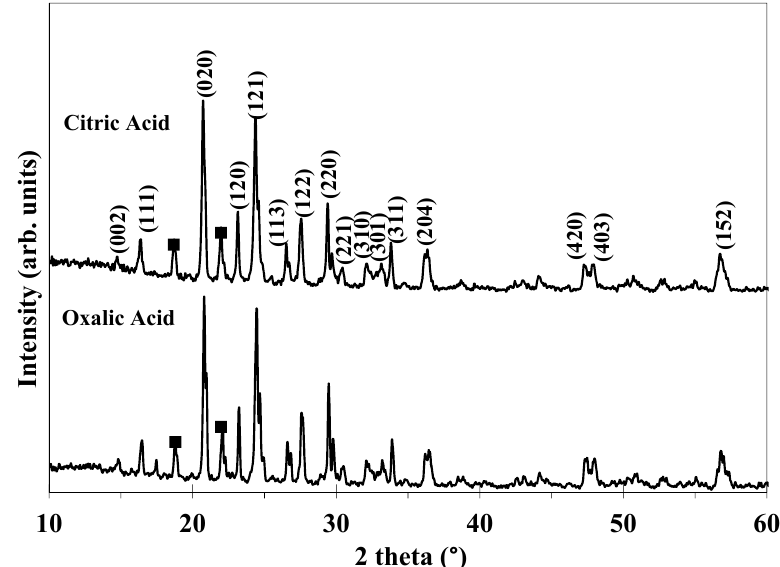
Figure 1. XRD patterns of the Li 3 V 2 P 3 O 12 (LVP) compounds obtained by the oxalic and citric acids, Symbol (cid:4) (Li 3 PO 4